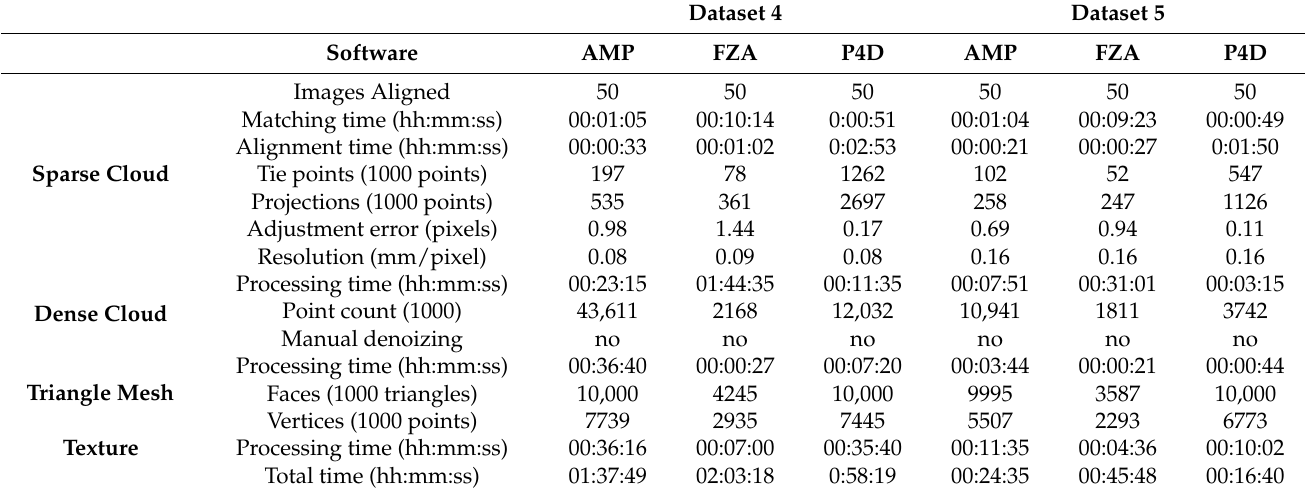
Table 5. Photogrammetric results, datasets 4 and 5.